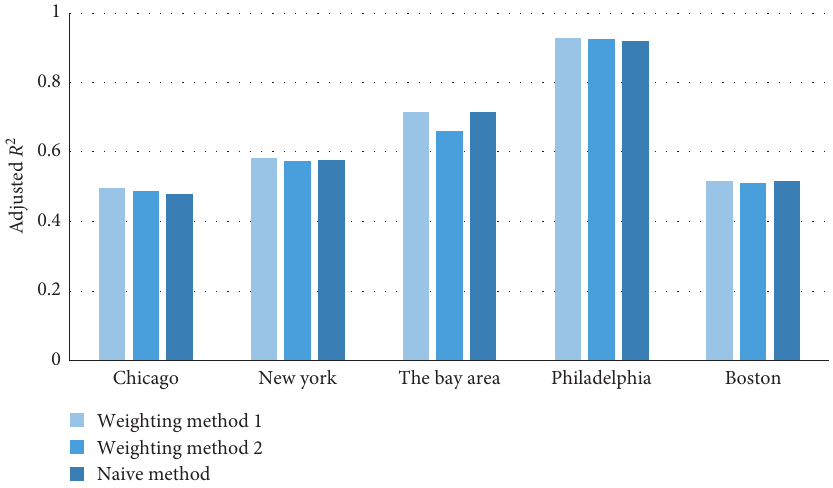
Figure 10: Linear regression result of two weighting methods and the na¨ıve method.